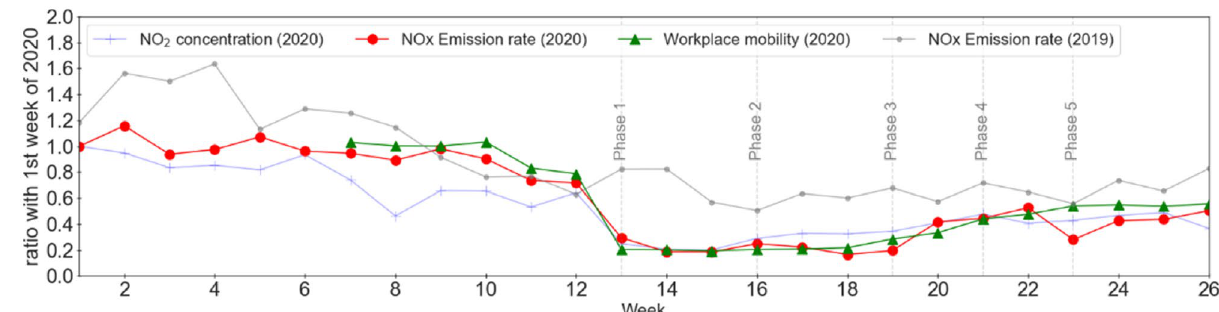
Figure 4. Mean NO 2 concentration, change in workplace mobility and NOx emission in 2020 and 2019 standardized with respect to the first week of January 2020 (6 January–12 January, 2020) over